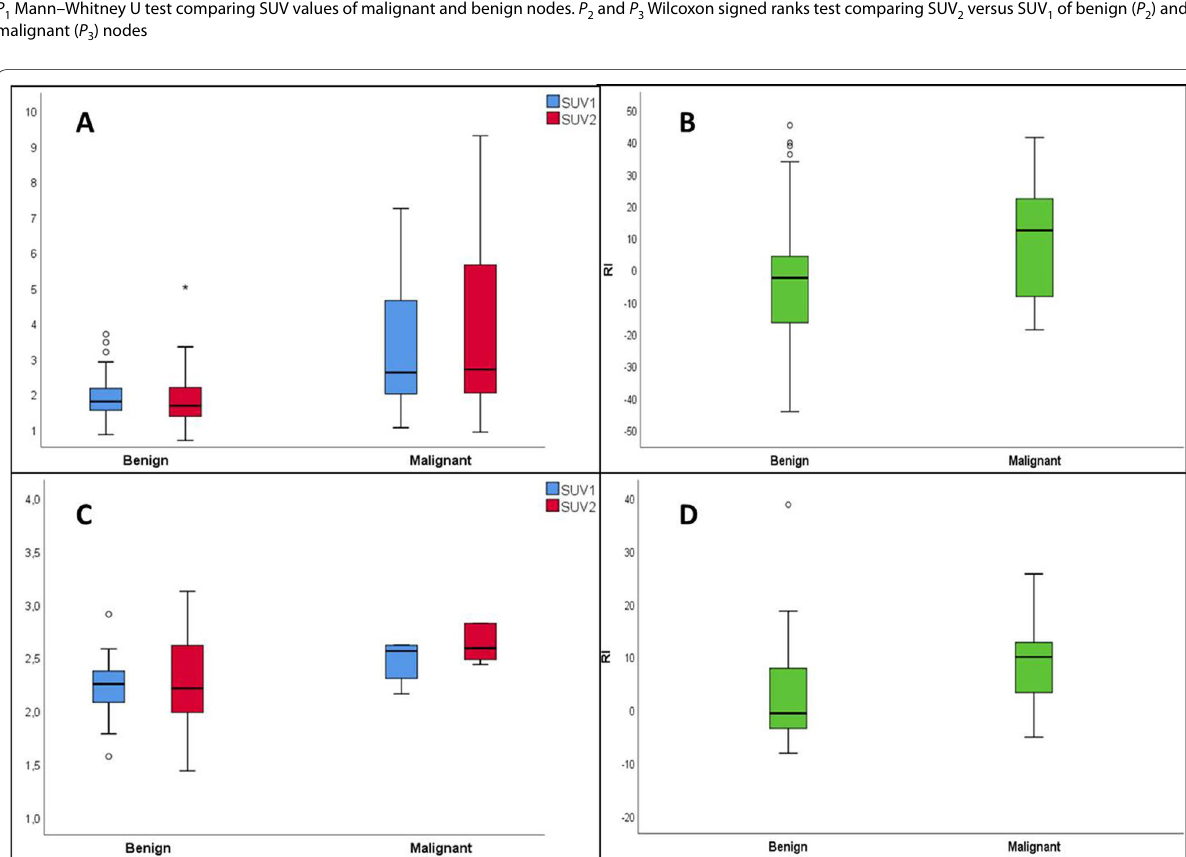
3*IQR or Q3 3*IQR), − +